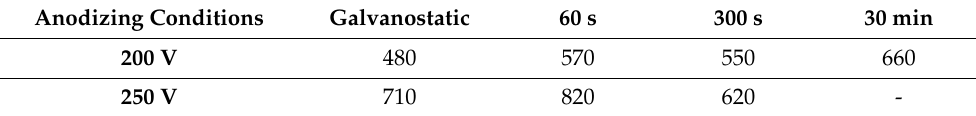
Table 1. Roughness values (nm) calculated on 100 µm × 100 µm scan size areas. Anodizing